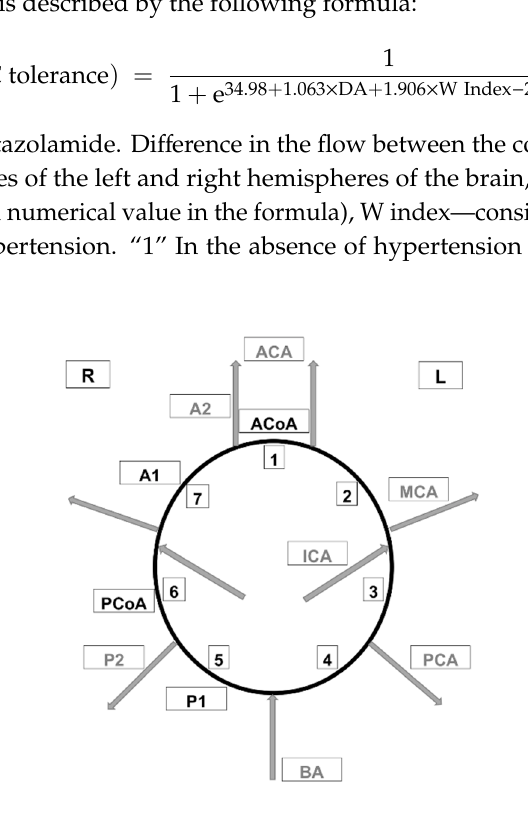
Figure 1. Arteries of the circle of Willis considered when calculating the W index. ACA—anterior cerebral artery, PCA—posterior cerebral artery, BA—basilar artery, AcoA—anterior communicating artery, PCoA—posterior communicating artery, MCA—middle cerebral artery, ICA—internal carotid artery, A1—1st segment of anterior cerebral artery, A2—2nd segment of anterior cerebral artery, P1—1st segment of posterior cerebral artery, P2—2nd segment of posterior cerebral artery.